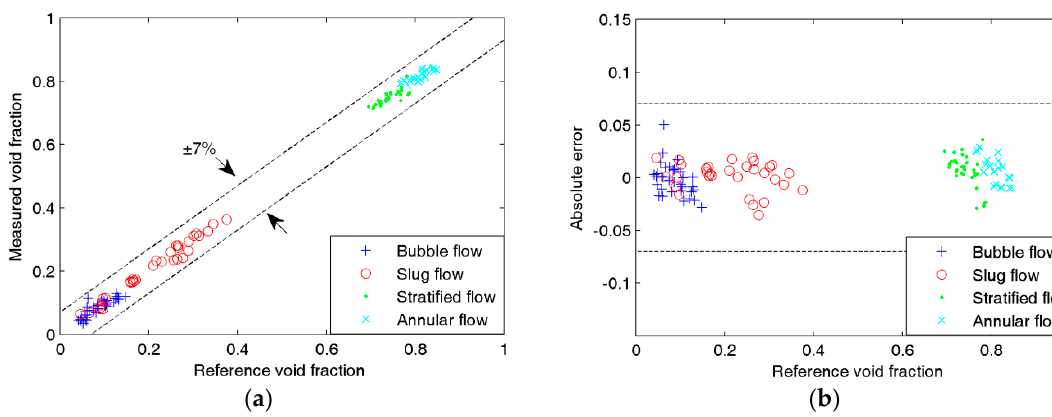
Figure 9. Experimental results of the void fraction measurement in the 3.04-mm i.d. chanel: ( a ) Comparison between measured and reference void fractions; ( b ) Absolute errors of the void fraction measurement.